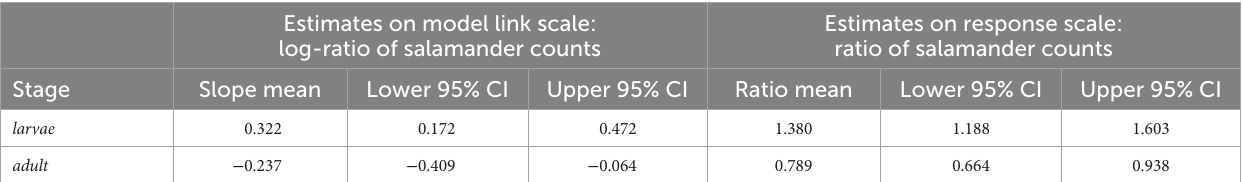
TABLE 3 Example of a numerical presentation of regression